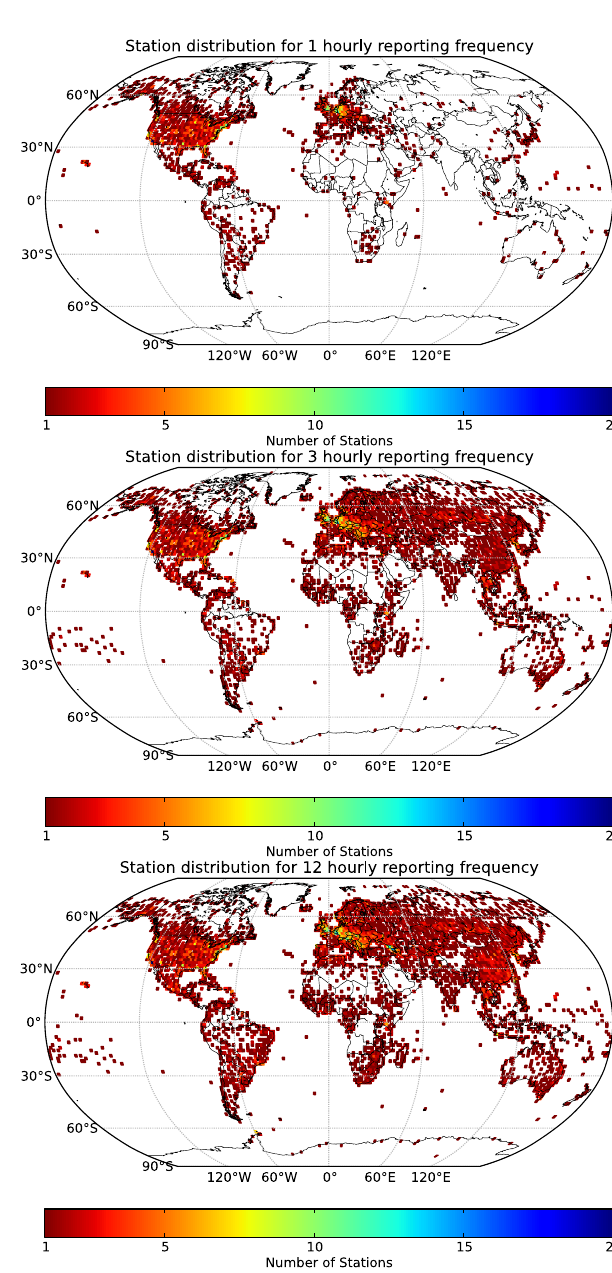
Fig. 2. Station distributions for different minimum reporting fre- quencies for a 1976–2005 climatology period. For presentational purposes we show the number of stations within 1 . 5 ◦ × 1 . 5 ◦ grid boxes. Hourly (top panel); 3-hourly (middle panel) and 12-hourly (bottom